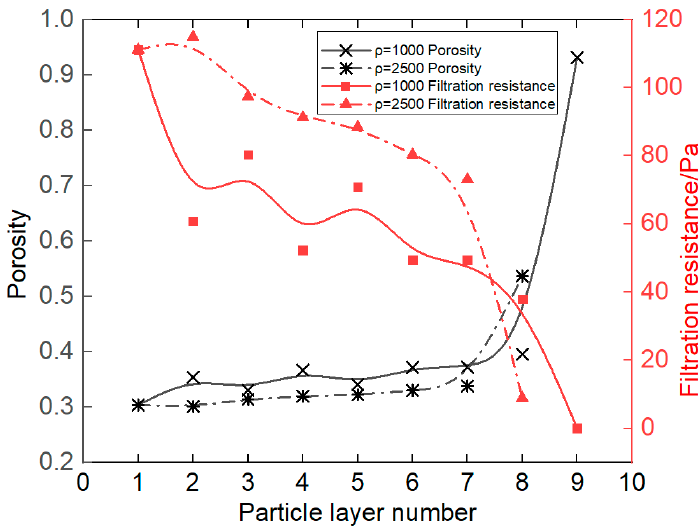
Figure 3. The effect of density on the filter cake porosity and the filtration resistance.